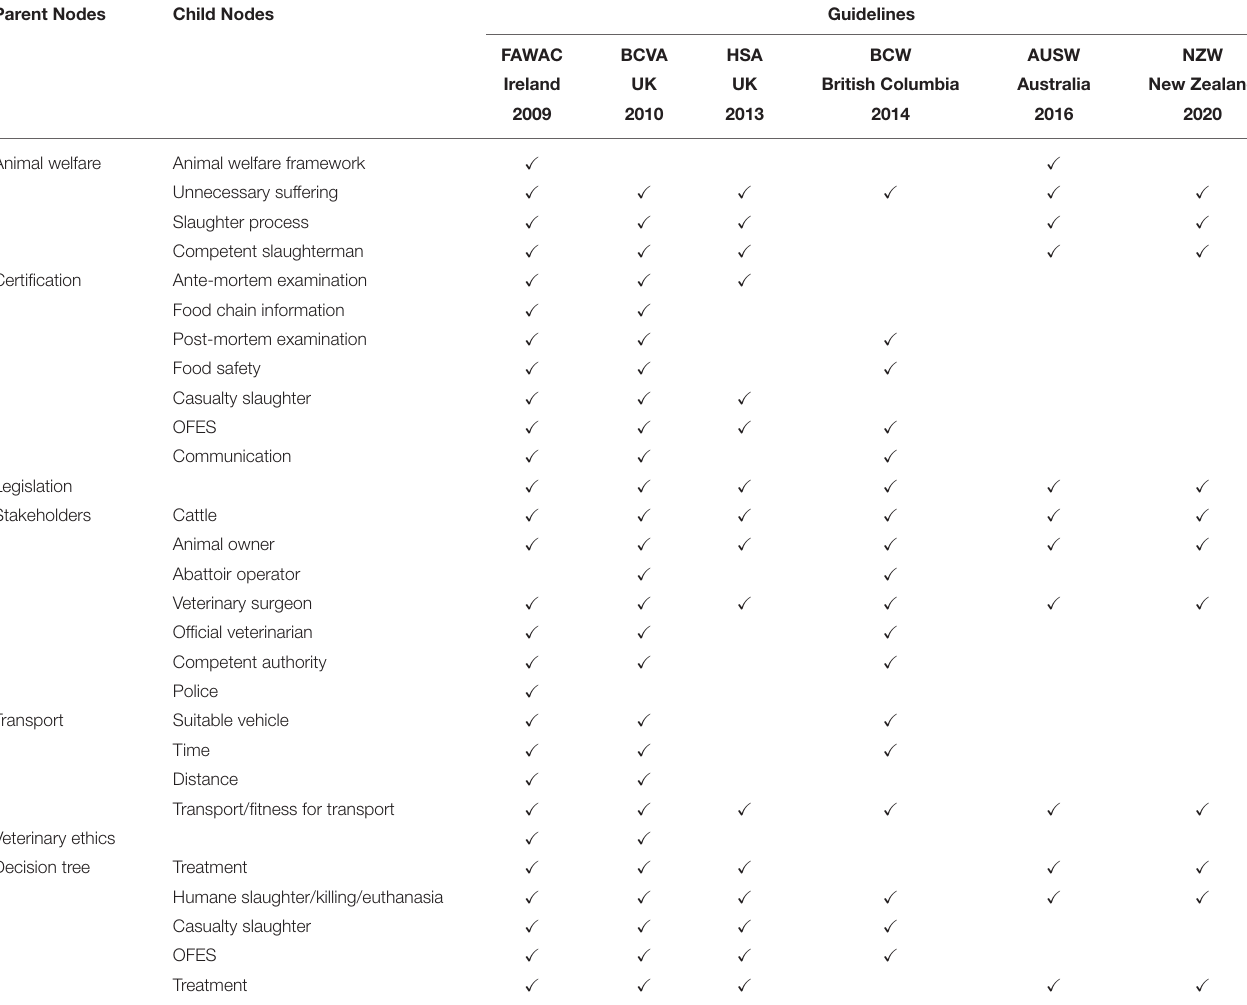
TABLE 1 | A comparison of the parent and child nodes from the thematic analysis of six guidelines for On Farm Emergency Slaughter (OFES) and Emergency Killing of Cattle in Ireland, the United Kingdom, Australia, New Zealand and British Columbia, Canada. Parent